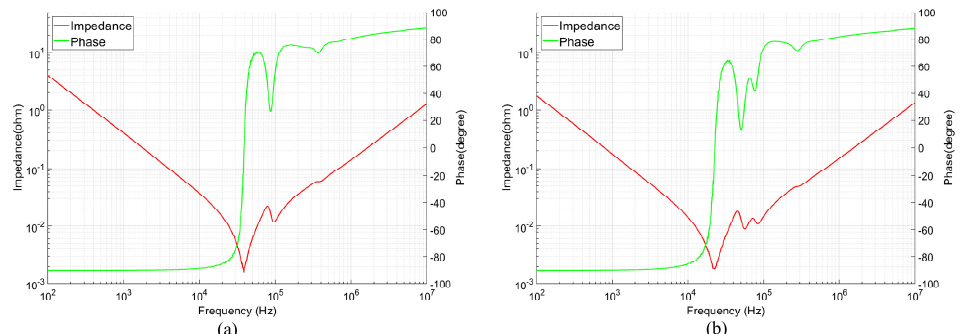
Figure 15. Impedance analysis of the DC ‐ link and flying capacitor. ( a ) The flying capacitor. ( b ) The DC ‐ ink capacitor.